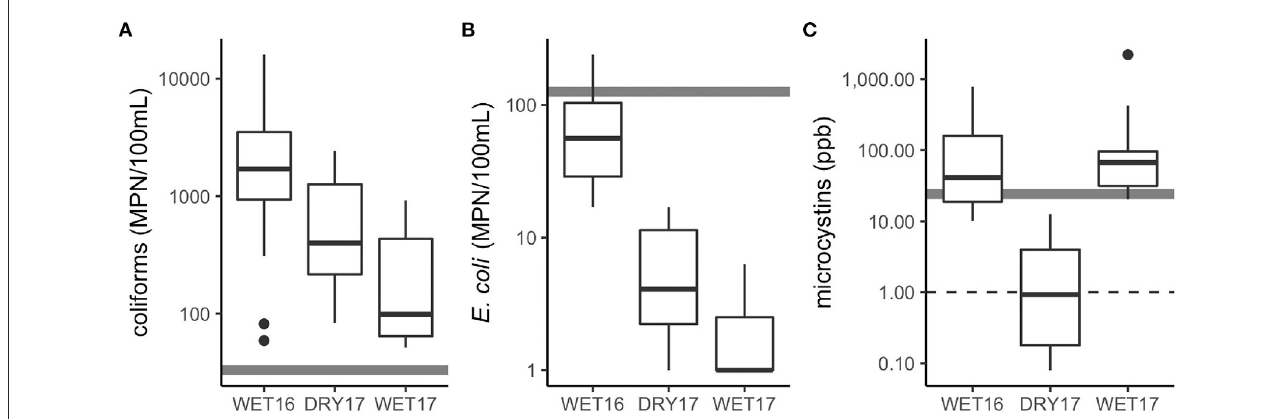
FIGURE3 Concentration of select water quality parameters across experiments including (A) total coliforms, (B) E. coli , and (C) total microcystins. Gray, solid line indicates water quality threshold for recreational use (Coliforms, E. Coli– USEPA, 2012, microcystins – World Health Organization, 2020), black, dashed line indicates water quality threshold for chronic exposure (microcystins – World Health Organization,